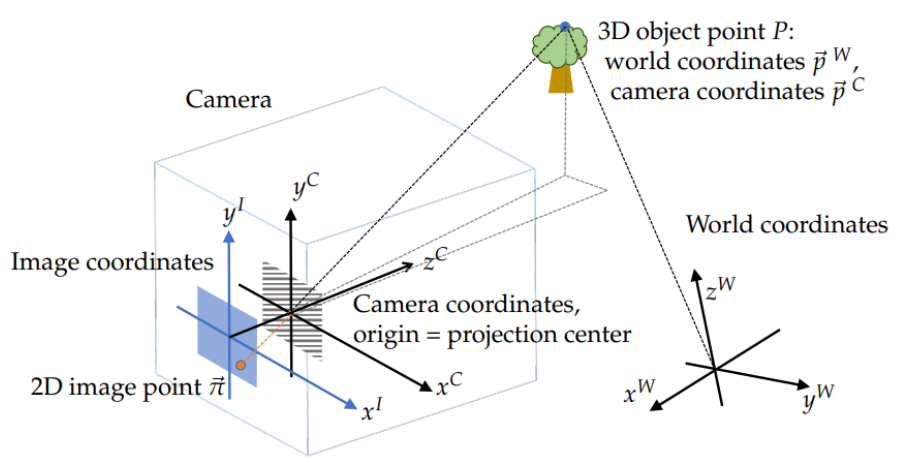
Figure 1. World, camera, and image plane coordinates for a pinhole